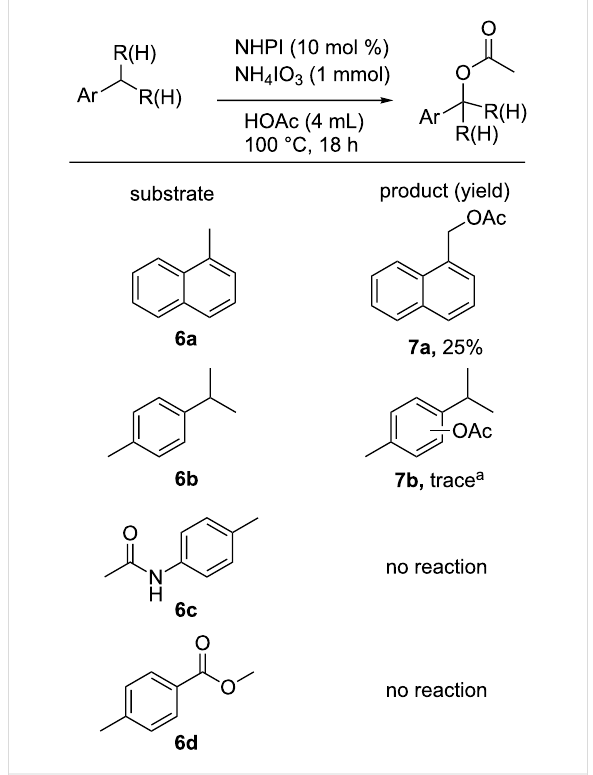
Figure 4: NHPI-catalyzed oxidation of substrates containing primary and tertiary benzylic C–H bonds. a Reaction performed using NaIO 3 (1 mmol) at 100 °C for 18 h. Product detected using